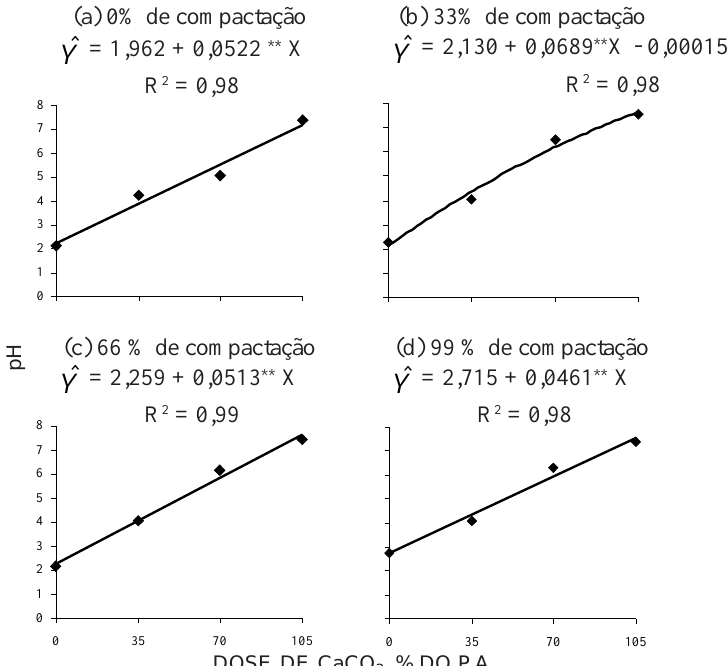
DOSE DE CaCO 3 , % DO P.A. Figura 2. Valores médios de pH nos lixiviados, considerando as doses de carbonato, dentro de cada nível de compactação. * e ** coeficientes significativos a 5 e 1%, respectivamente.